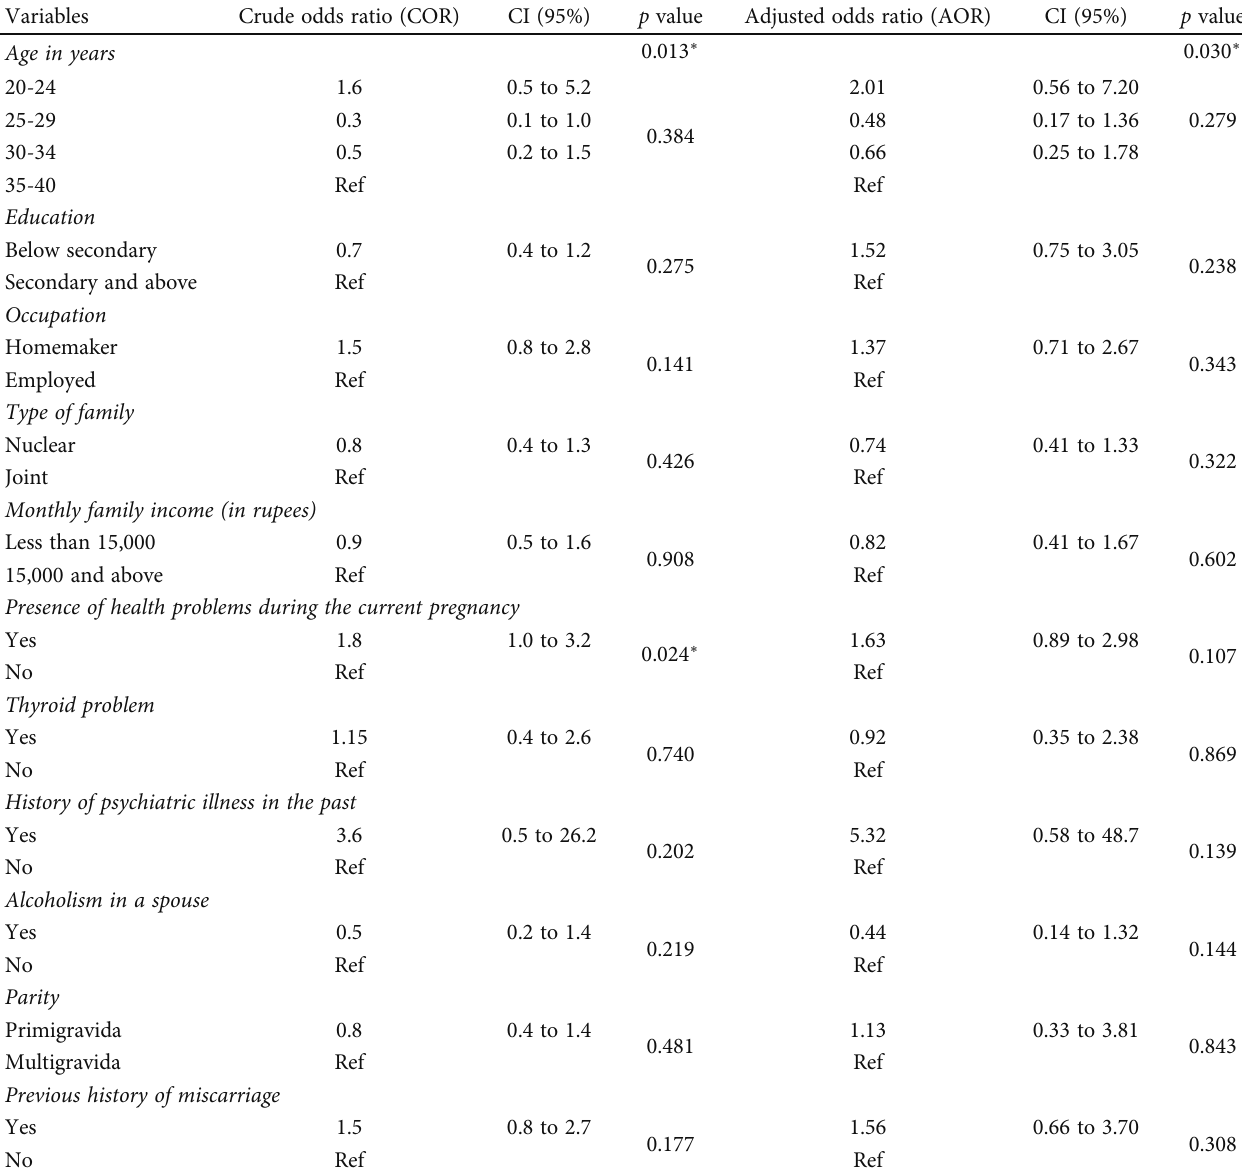
Table 3: Bivariate and multivariate analyses of independent variables against antenatal